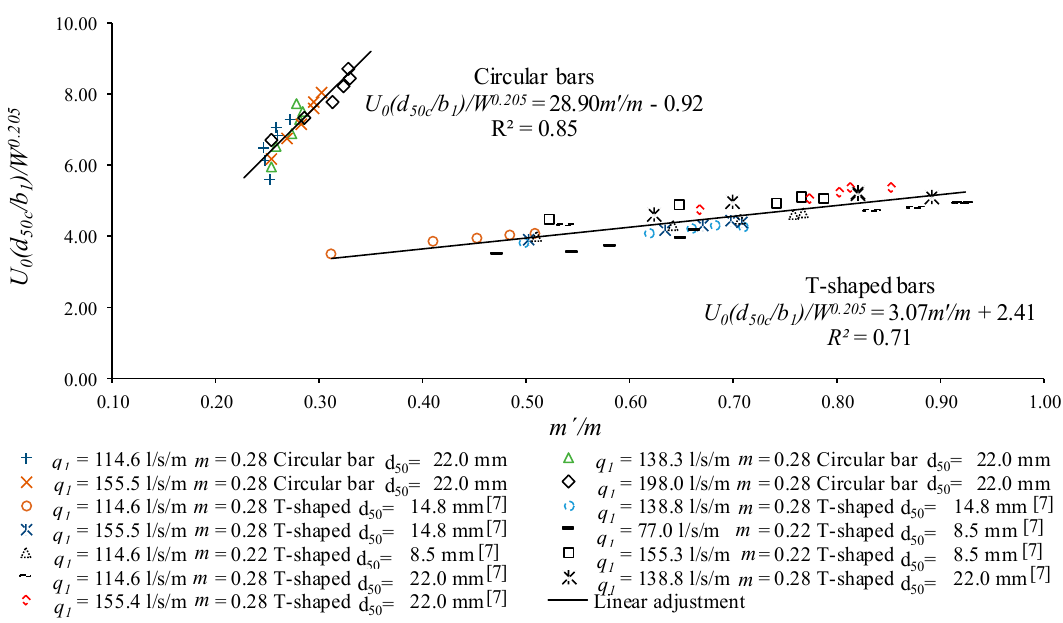
(cid:48) /m ratio as a function of the values U